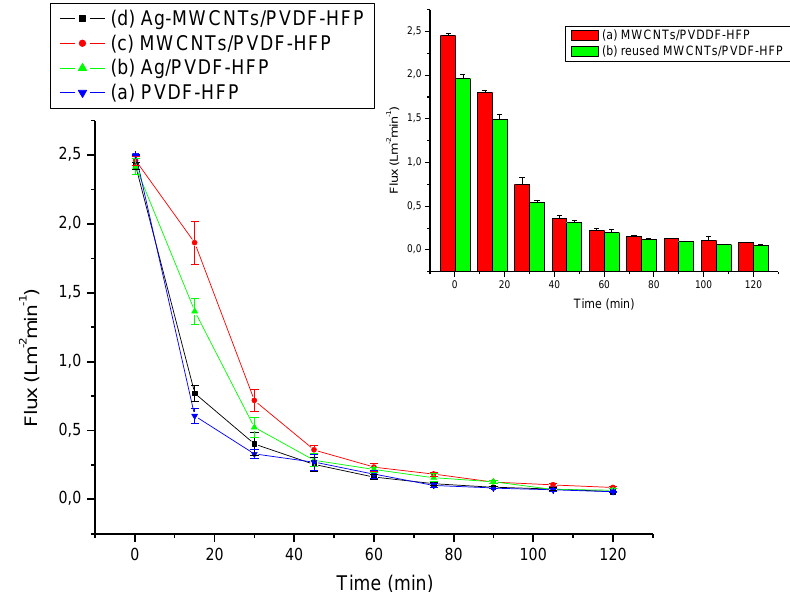
Figure 7. Filtrate flux for salted water (2000 ppm) filtered through the ( a ) PVDF-HFP, ( b ) Ag/PVDF-HFP, ( c ) MWCNTs/PVDF-HFP, and ( d ) Ag-MWCNTs/PVDF-HFP membranes, and the insert showing the 1st and 3rd filtration cycles of filtrate flux for MWCNTs/PVDF-HFP membrane.